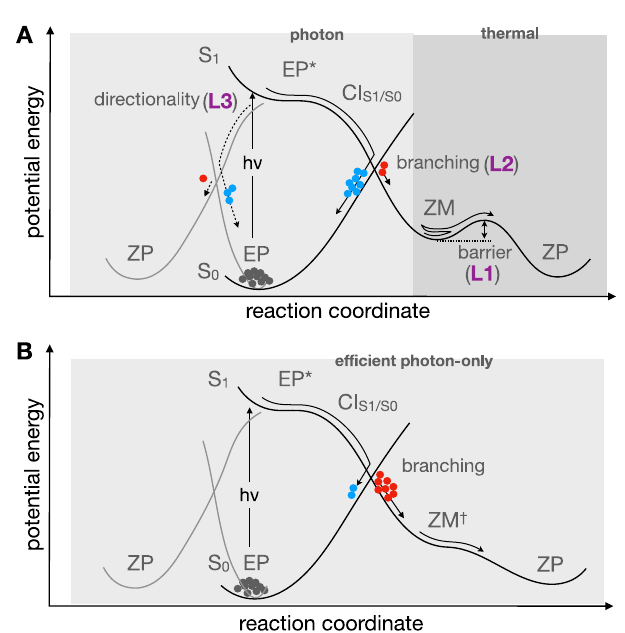
Fig.2|Schematicrepresentationofthereactionpathforthe fi rsthalfofLDRM h ν working cycle starting from an E P con fi guration. A Classic unidirectional E P ! Z M ! T (cid:2) Z P half-cycle withthe possibility of lossof E P ! h ν Z P directionality. Thelabels marking the system potential limitations (see text) are given in purple. B Target h ν Z Phalf-cycle.Theacronyms E P, Z P,etc. unidirectional,ef fi cient,and ultrafast E P ! standforthestructureswithaspeci fi chelicity(PorM)inaspeci fi ccon fi guration( Z or E ). CI stands for conical intersection. The gray dots represent the initial struc- tures, the red dots represent the productive trajectories, and the blue dots the unproductive